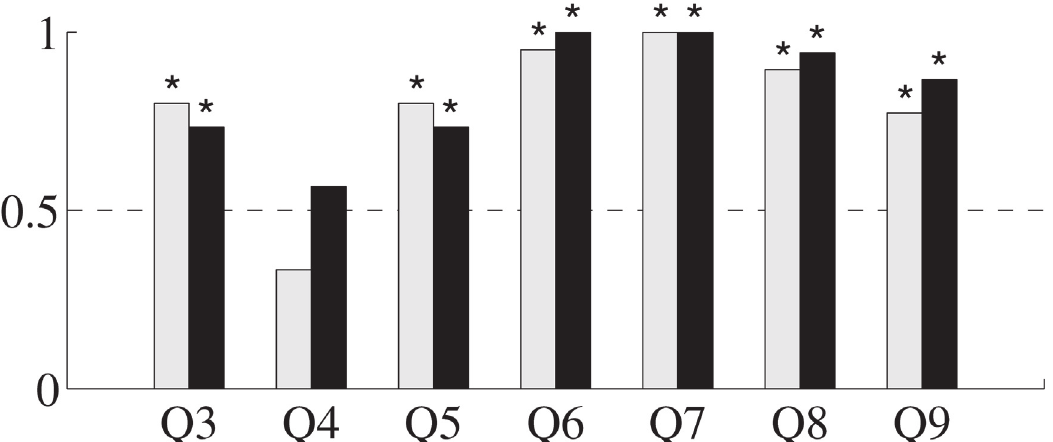
Fig 4. Bar plot of survey results for questions Q3 – Q9 (see Table 1). Gray bars indicate the proportion of positive responses from patients, while black bars refer to healthy subjects (for Q6 – Q9, neutral responses are omitted). An asterisk above the bar indicates a significant difference from chance. For Q6 – Q9, the fraction of neutral responses is: 0.17, 0.57, 0.43, and 0.50 for healthy subjects, respectively, and 0.33, 0.63, 0.37, and 0.27 for patients.